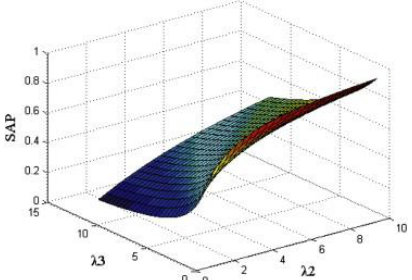
Figure 10. Relationship between the attack rate 𝛌 𝟐 , resume rate 𝛌 𝟑 and SAP.